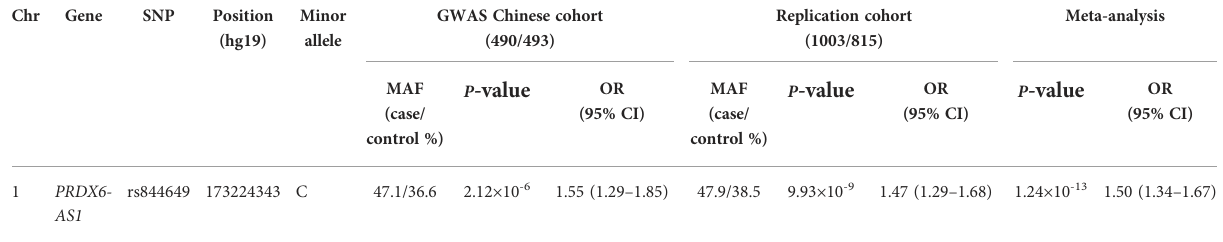
TABLE 1 Association of rs844649 PRDX6 - AS1 with systemic lupus erythematosus (SLE) susceptibility. Chr Gene